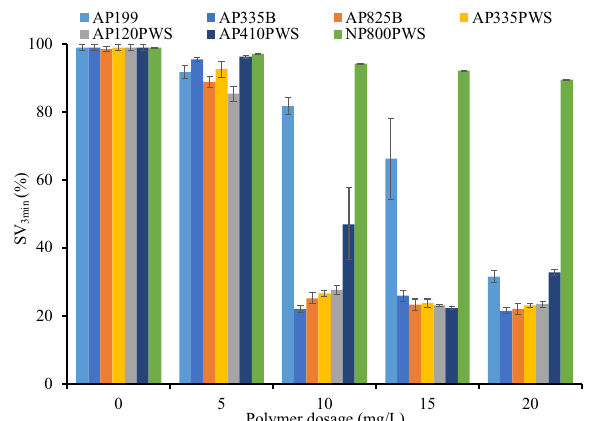
Fig. 5 Sludge volumes generated after 3 min of settling (SV 3min ) in softening with ballasted fl occulation (SBF) with different dosages of various polymer fl occulants (color coded) ( n = 3, means ± standard deviations). Six types of anionic polymers (AP199, AP335B, AP825B, AP335PWS, AP120PWS, and AP410PWS) and one nonionic polymer (NP800PWS) were tested.